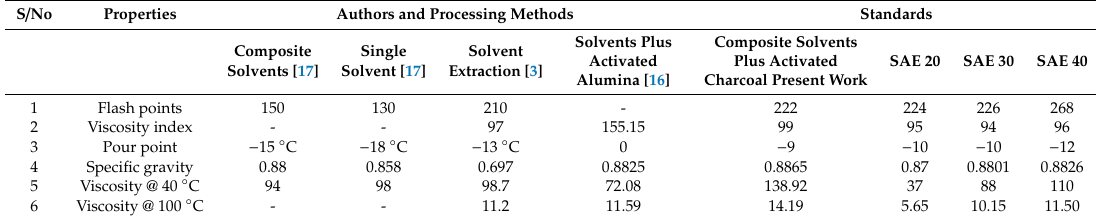
Table 4. Comparison of results by solvent extraction for di ff erent studies with SAE